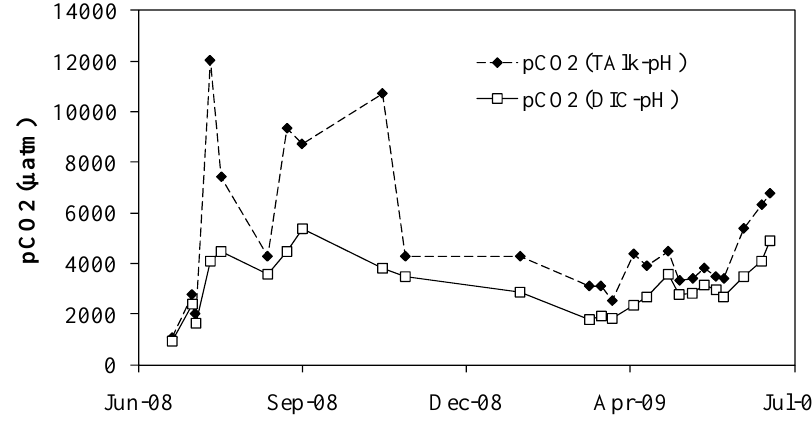
Fig. 3. Partial pressure of carbon dioxide calculated from TAlk and pH ( p CO 2 - TAlk - pH ) , as well as from DIC and pH ( p CO 2 - DIC - pH ) , at one sampling site on the Oyster Figure 3. Partial pressure of carbon dioxide calculated from TAlk and pH (pCO at one sampling site on the Oyster River.